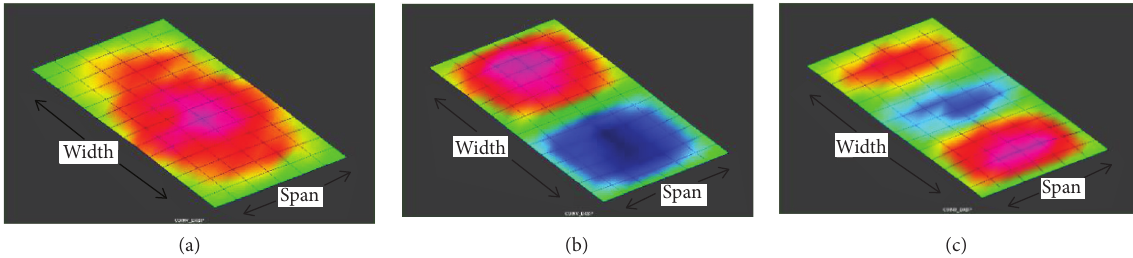
Figure 6: First three vibration mode shapes of the test floors. (a) Mode 1. (b) Mode 2. (c) Mode 3.